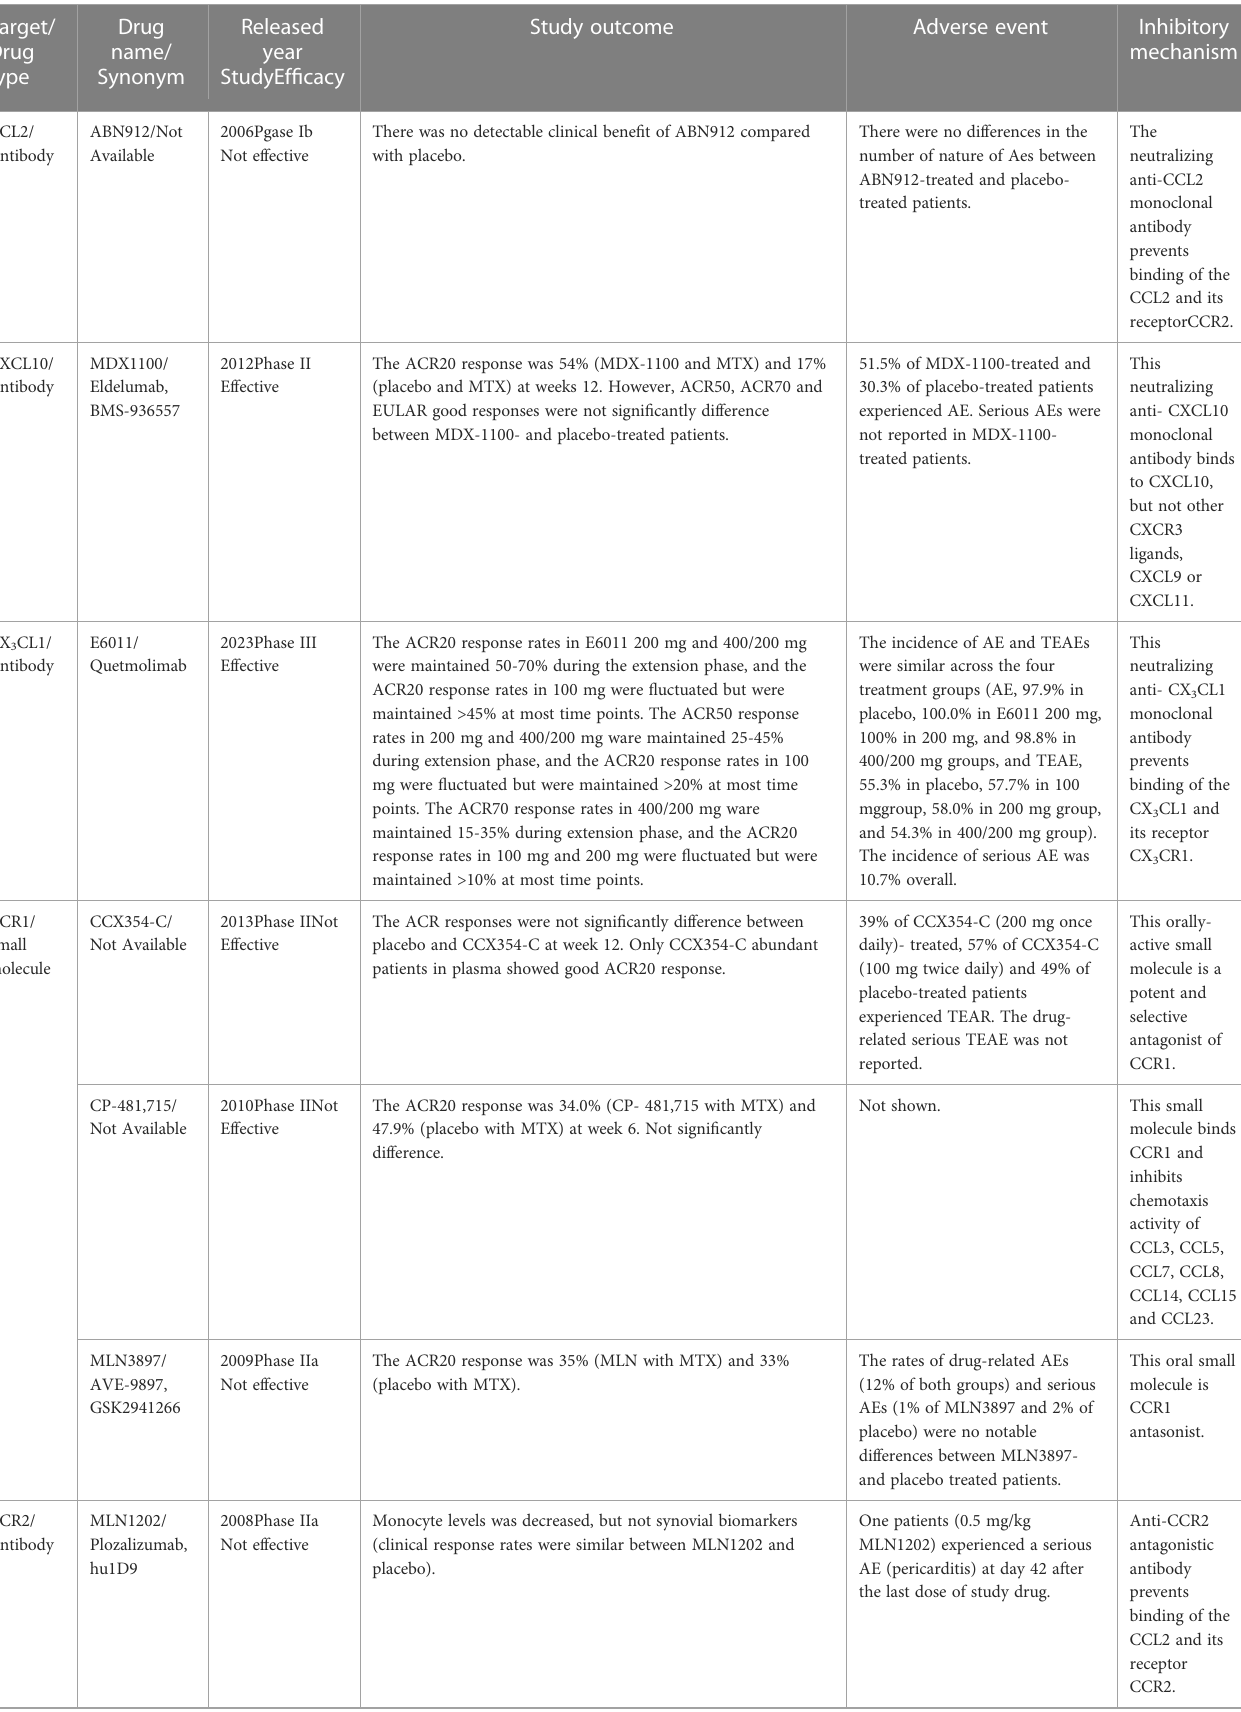
TABLE 6 The chemokine ligands and receptors-targeted therapy in RA